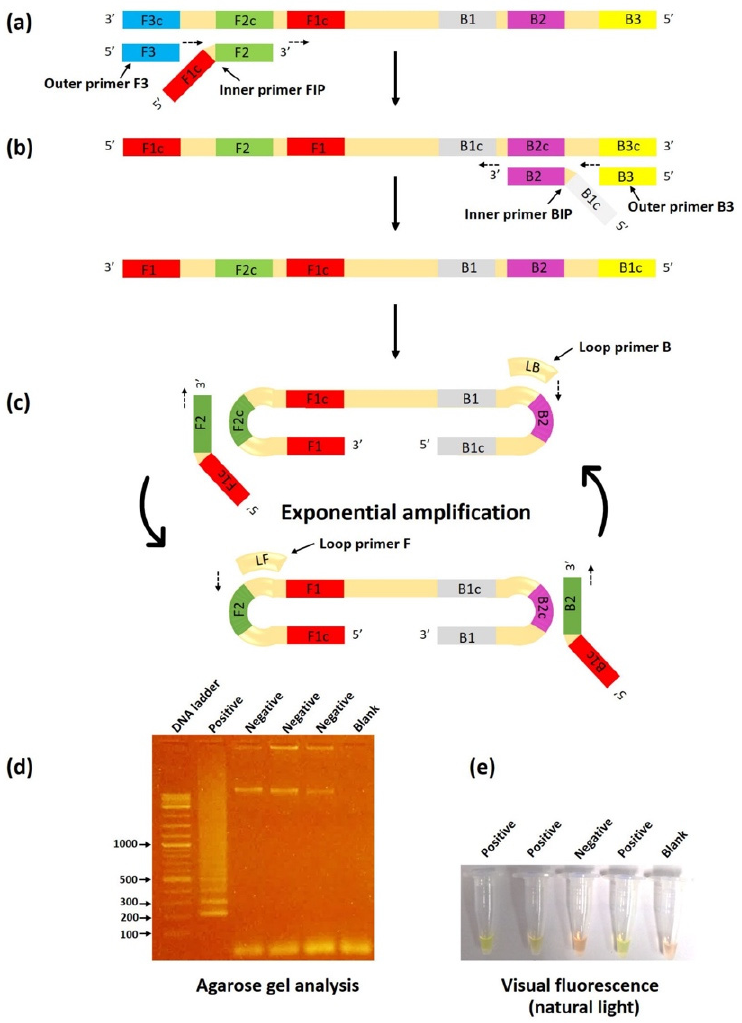
Figure 9. Schematic illustration of the LAMP assay for detecting P. insidiosum . ( a ) In the initial step of the LAMP method, the F2 portion of the FIP primer anneals the F2c region of the DNA template to form a new DNA strand using the Bst DNA polymerase. The F3 primer anneals the F3c region of the target DNA to initiate sequence elongation, causing displacement of the FIP ‐ linked strand. ( b ) The displaced strand forms a loop at the 5’ end and subsequently serves as a template for DNA amplification using the primers BIP and B3. ( c ) As a result, a loop is formed at both ends. The obtained double stem ‐ loop DNA (a dumbbell ‐ like structure) enters multiple amplification cycles for exponential production of the target DNA. The final LAMP product is a mixture of various sizes of stem ‐ loop DNAs. ( d ) The LAMP products can be detected as a ladder pattern observed on an electrophoresis agarose gel. ( e ) Naked ‐ eye observation of an amplification result under natural light after adding a fluorescent intercalating dye (SYBR Green I) shows the striking color change from orange to bright green, indicating a positive LAMP reaction. The diagram is adapted from the references [68,69] and the New England Biolabs website (https://international.neb.com, accessed on 6 November 2022).